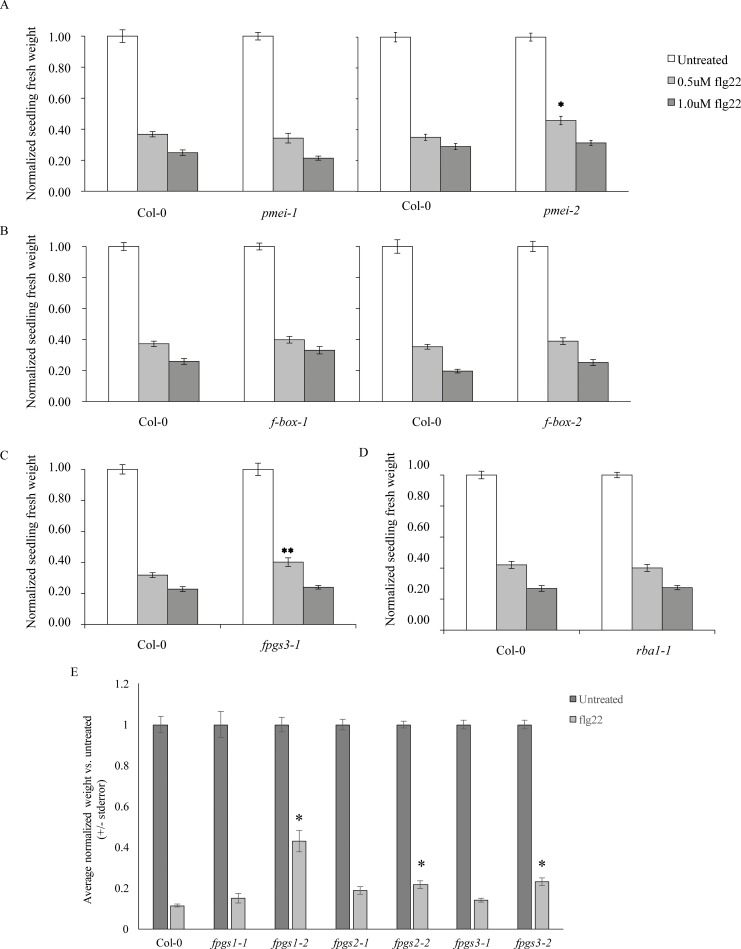
Seedling growth inhibition assay.Five-day-old seedlings of the indicated genotypes were treated with 0.05uM (low) or 1.0uM (high) flg22 peptide and grown for an additional 14 d. Fresh seedlings weights were then recorded and normalized to the average untreated weight within each genotype. A. Pectin methylesterase inhibitor (PMEI) (At5g64640) knockouts versus untreated, three (pmei-1) and four (pmei-2) biological replicates of 12 seedlings per treatment. B. F-box domain-containing gene (At5g15660) knockouts versus untreated, three (f-box-1) and two (f-box-2) biological replicates of 12 seedlings each. C. Folylpolygutamate synthetase 3 (FPGS3) (At3g55630) knockout versus untreated, three biological replicates. D. TIR-X domain-containing gene (At1g47370), three biological replicates. Asterisks summarize ANOVA results across all experiments for tests of similarity of means between the mutant genotype and wild-type plants treated with the same concentration of flg22. E. FPGS1 (At5g05980), FPGS2 (At3g10160), and FPGS3 (At3g55630) versus untreated, three biological replicates. (Tukey's simultaneous test: * P < 0.05; **P < 0.005; no asterisk, P > 0.05).